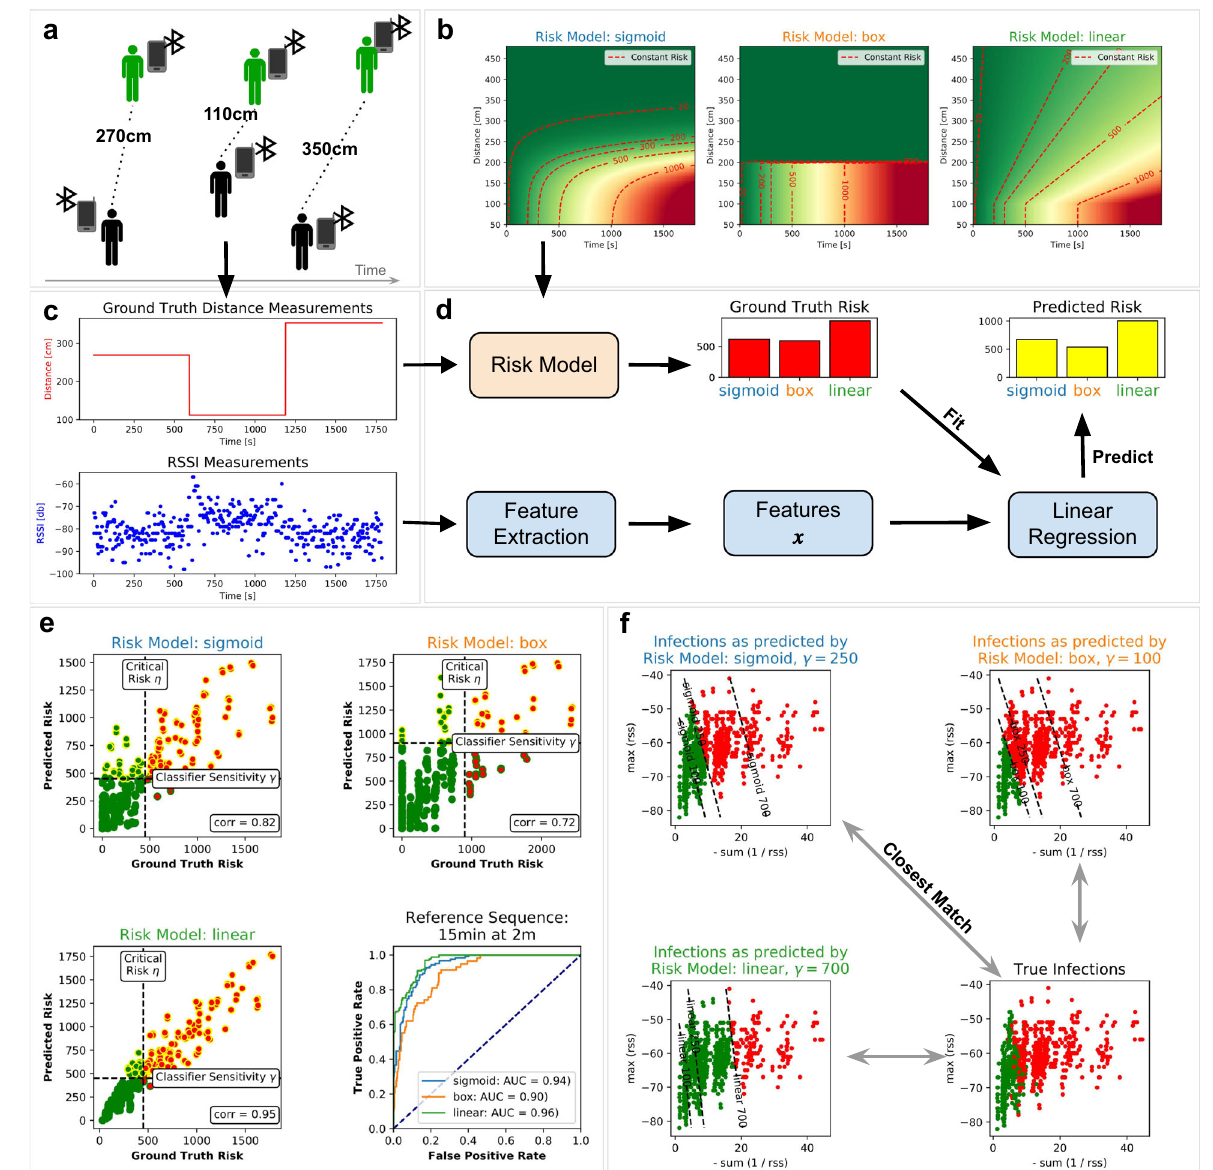
Fig. 1 Overview of the proximity tracing concept and results. a Typical infection scenario in a public space (e.g. a supermarket), where close contact between an infected and a contact person is established over a long enough period of time. b An epidemiological risk function translates a time series of contact distances into infectiousness scores, which are then used to label the encounters in the training data set. c Example of a raw RSSI time series of the BLE signal, as well a corresponding contact distances. d We train a linear regression model to predict the infectiousness scores obtained from a given risk model. The linear regression receives as input a list of features, which were derived from the raw RSSI data. e The predictions of the linear regression model correlate strongly with the ground truth risk (up to 0.95 for the linear risk model). For a fi xed critical risk threshold η the approach achieves high true positive rates with very few false classi fi cations. f To this day only little is known about spreading behaviour of SARS-Cov-2. In this work, we calibrated our epidemiological models according to the latest recommendations of epidemiologists 16 . After large-scale deployment of proximity tracing technologies, it will be possible to compare the predicted infection events with the actually measured ones. This may help to re fi ne epidemiological